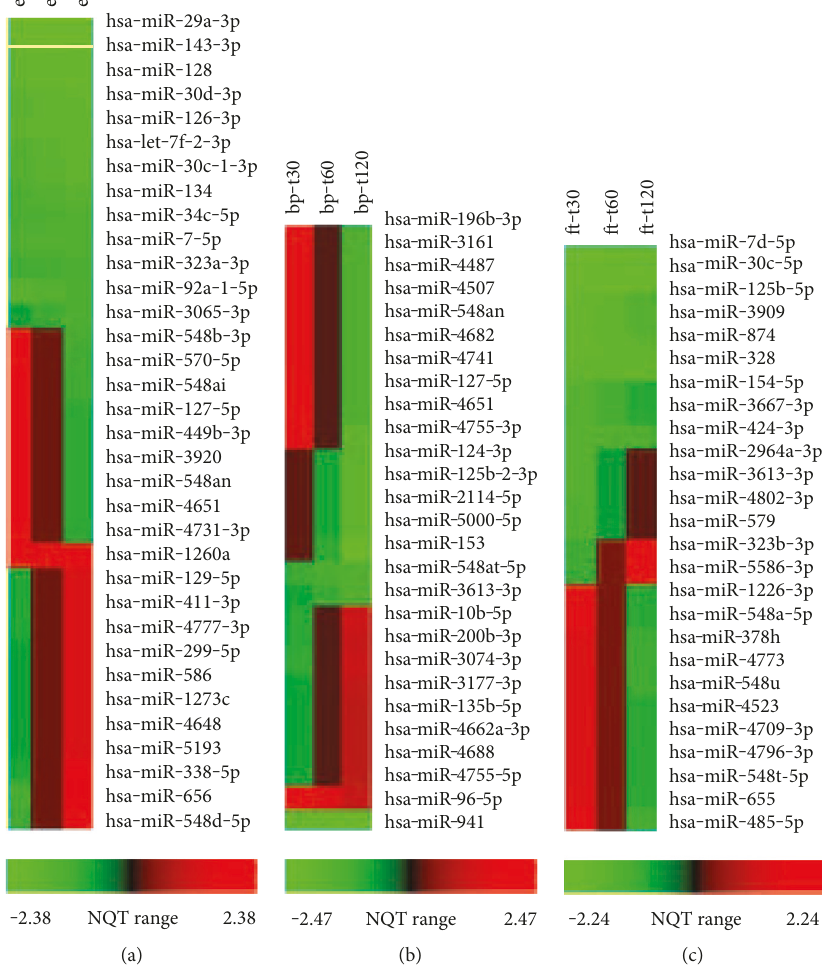
Figure 1: Heatmap of 87 DE miRNAs which passed a fi rst round screening test from RNAseq analysis. (a) 34 in E. coli - (ec-) exposed hPBMCs, (b) 27 in B. pseudomallei - (bp-) exposed hPBMCs, and (c) 26 in F. tularensis - (ft-) exposed hPBMCs. For each organism, the three time points (t30, t60, and t120) are shown from left to right. The x -axis indicates the range of normal quantile transformed (NQT)